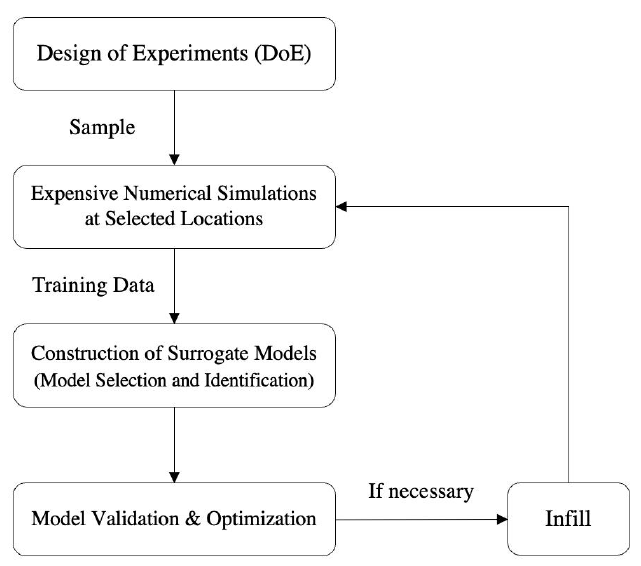
Figure 5. The process of building surrogate